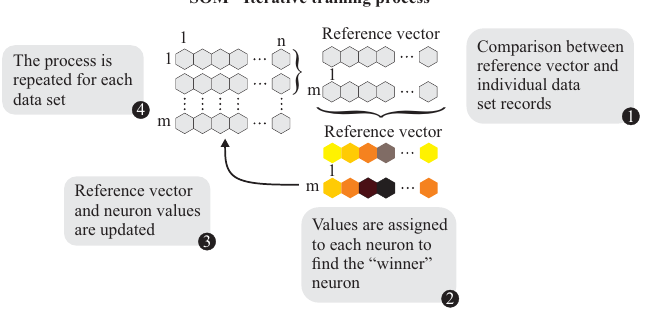
Figure 8. Self Organizing Map (SOM) iterative training (step 1 comparison between reference vector and individual data, step 2 assigned values to get the winner, step 3 vectors are updated, step 4 go to step one until the stop condition is achieved).